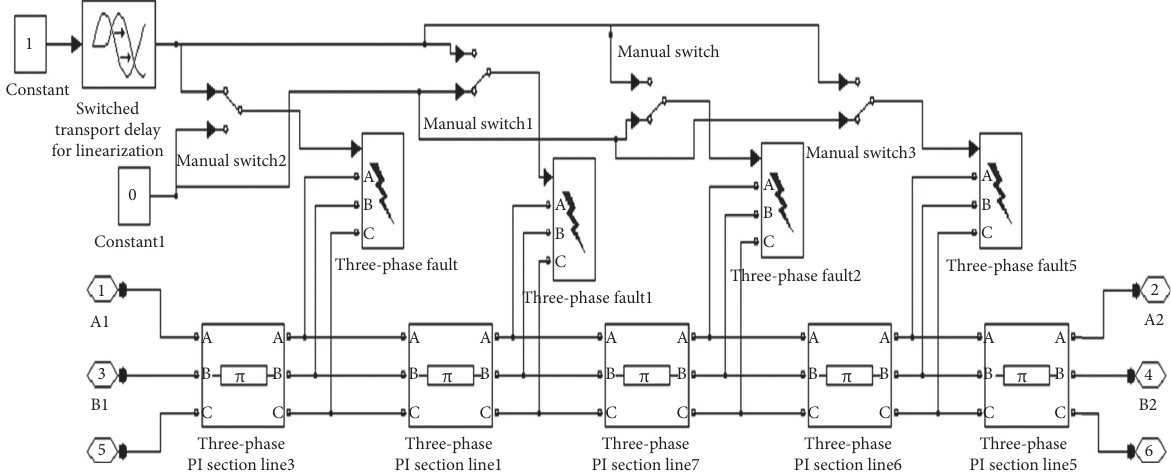
Figure 3: Simulink model for the distribution subsystem of Figure 2 with the faults switched on manually.